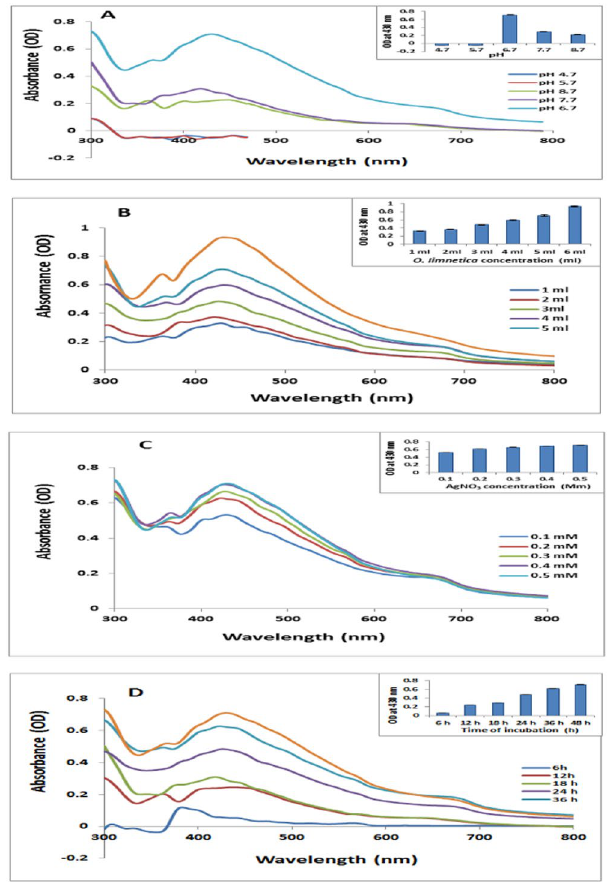
AgNO 3 concentrations (mM) [0.1, 0.2, 0.3, 0.4 and 0.5]. ( D ) UV-Visible spectra of O-AgNPs at different time intervals (h) [6, 12, 18, 24, 36 and